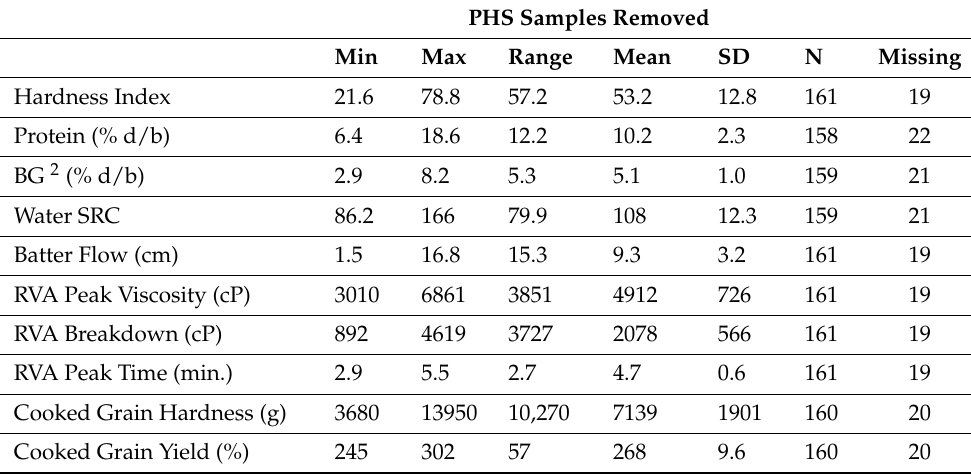
Table 2. Summary statistics of measured food-barley traits after samples with PHS 1 were removed (see also Table